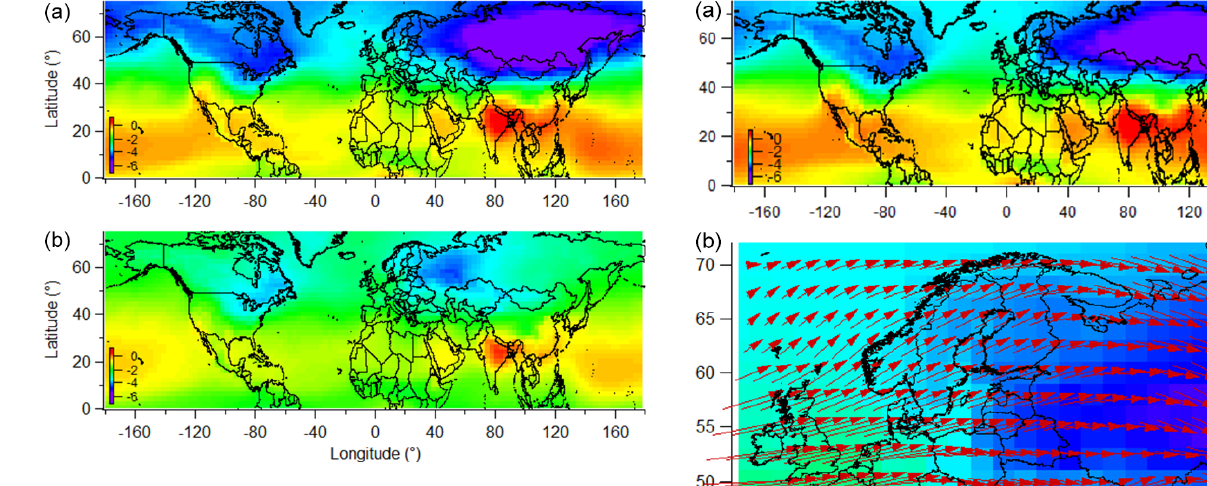
Figure 10. Total column (cid:49) XCO 2 (in ppm) from the CarbonTracker control (a) and masked ( b , Eurasian boreal flux is masked) runs for June–August 2012 (3 ◦ × 2 ◦ spatial resolution). MLO trend from each individual scenario is removed before the (cid:49) XCO 2 calculation. The same color scale is used as in Fig. 9a. Partial column (cid:49) XCO 2 patterns for the free troposphere (800 to 330hPa) and lower tropo- sphere (below 800hPa) are provided in the Supplement.